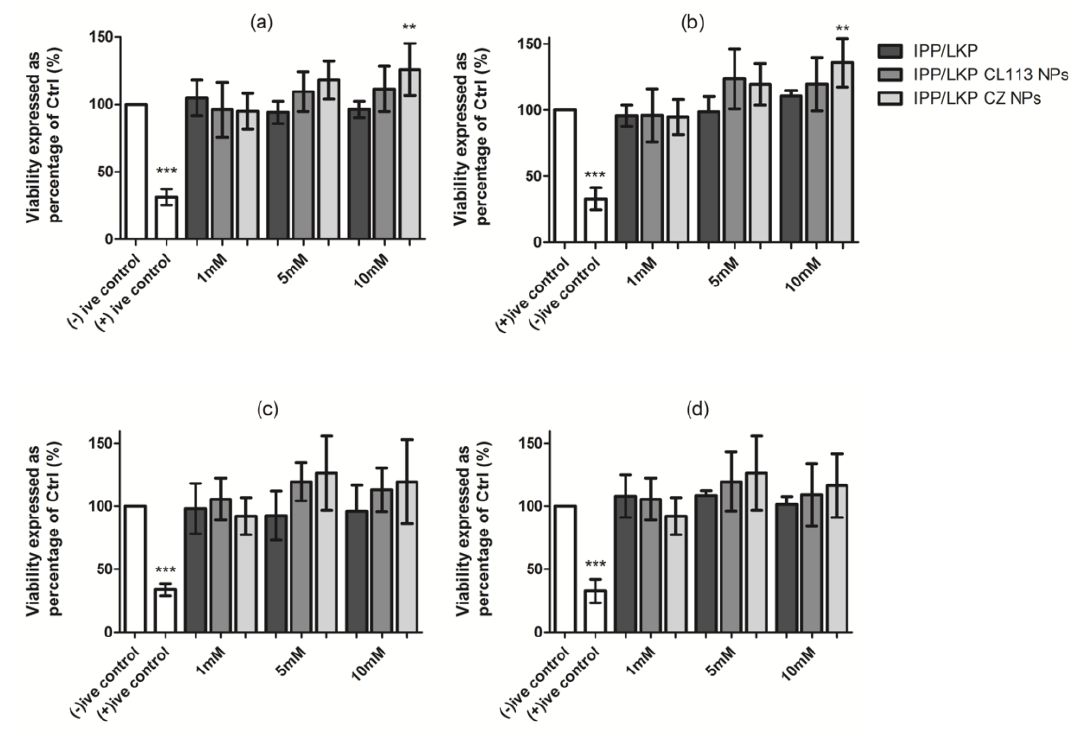
Figure 7. Comparison of cytotoxicity of native LKP, LKP NP and LKP CZ NP exposed to ( a ) Caco-2 cells lines (24 h) and ( b ) HepG2 cell lines (72 h). Native IPP, IPP NP and IPP CZ NP exposed to ( c ) Caco-2 cells lines (24 h) and ( d ) HepG2 cell lines (72 h). Triton X (0.05% w / v ) and 100% cell viability (no treatment) were used as the positive and negative control. One-Way ANOVA with Dunnett’s post-test *** p < 0.001, ** p < 0.01. Each value represents the mean ± SD, n = 3 independent experiments for each concentration and time point with replicates of three.